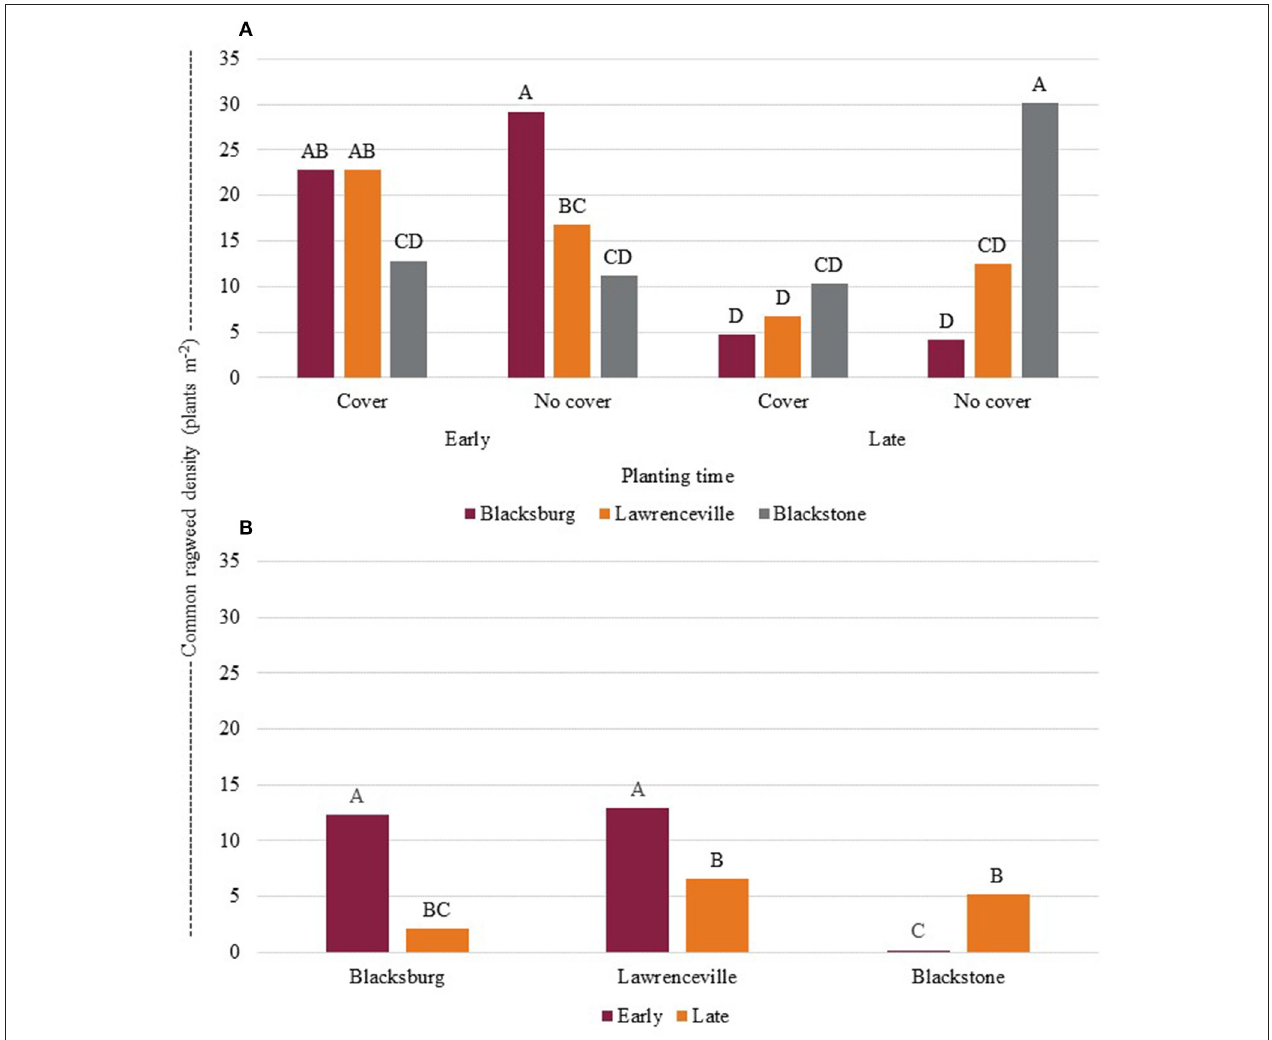
FIGURE 5 | Common ragweed density (A) at POST herbicide application by location, planting time, and ± winter cover (cereal rye for early planting and winter wheat for late planting) in year 2 of the experiment. POST herbicide applications were made when common ragweed reached 30cm in height and (B) at soybean harvest by location and planting time in year 2 of the experiment. Means are considered statistically different when they do not share a letter according to Fisher’s Protected LSD ( P = 0.05)